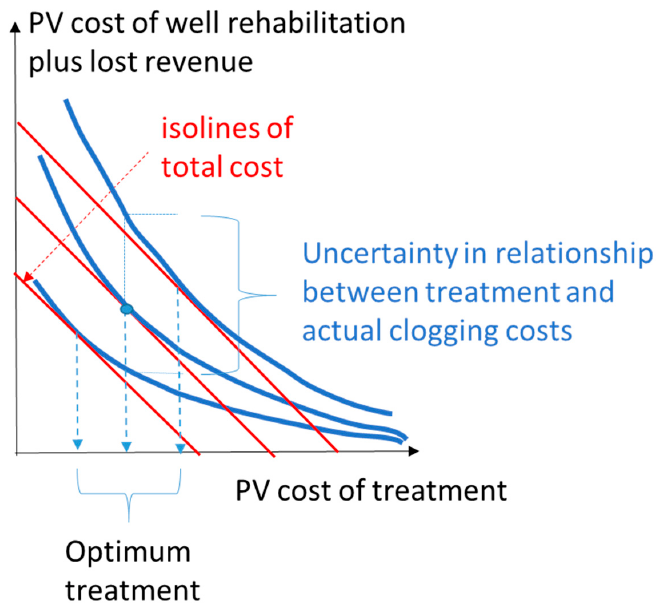
Figure 3. Schematic showing the present value of cost of well rehabilitation and lost revenue due to clogging as a function of the present value of any treatment that reduces the likelihood and severity of clogging. Optimum treatment minimizes the sum of these costs, assuming that Case B of Figure 2 applies. This diagram also assumes a continuum of treatment costs such as would occur when adjusting blends of water from more than one treatment process.